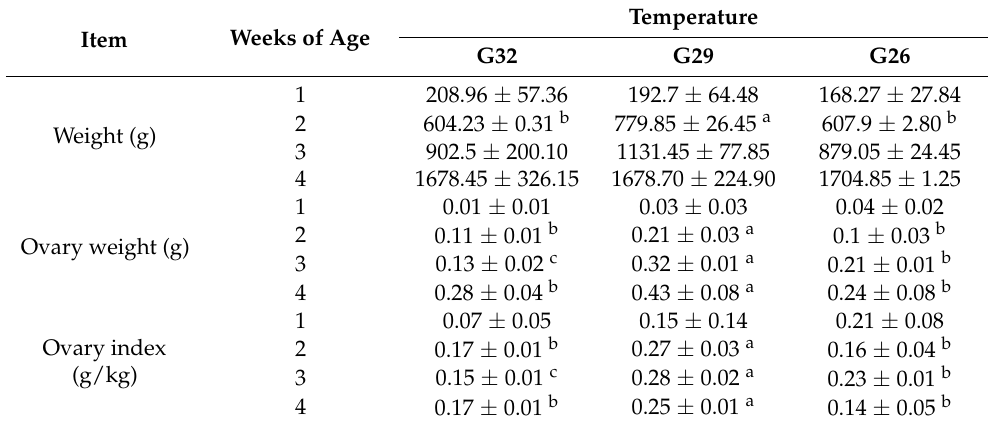
Table 4. Effects of temperature on body weight, ovarian weight and index of goslings at each week of